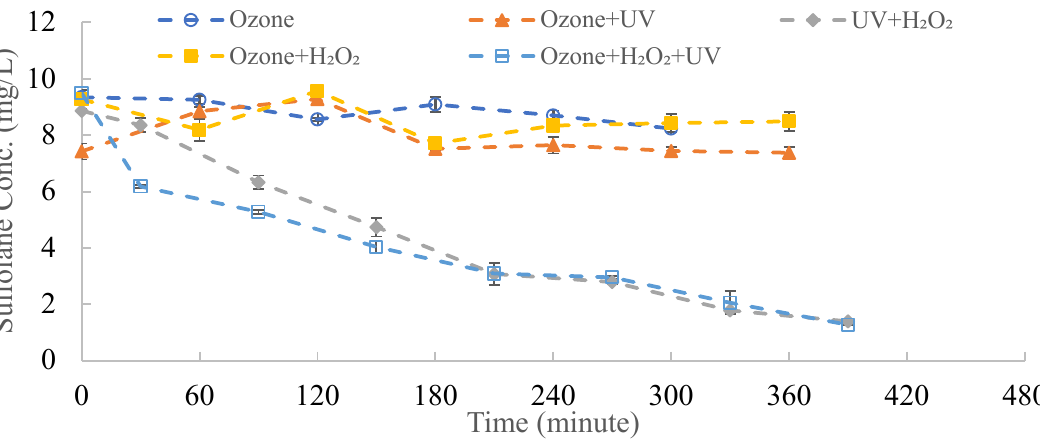
Figure 4. Degradation of sulfolane in Water II with combinations of different oxidants: [H 2 O 2 ] = 40 mg/L, ozone rate = 30 g/h.